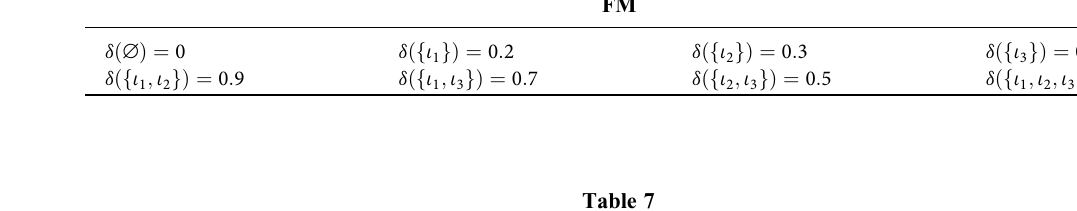
Comparison of classification result of Example 3 Similarity measures